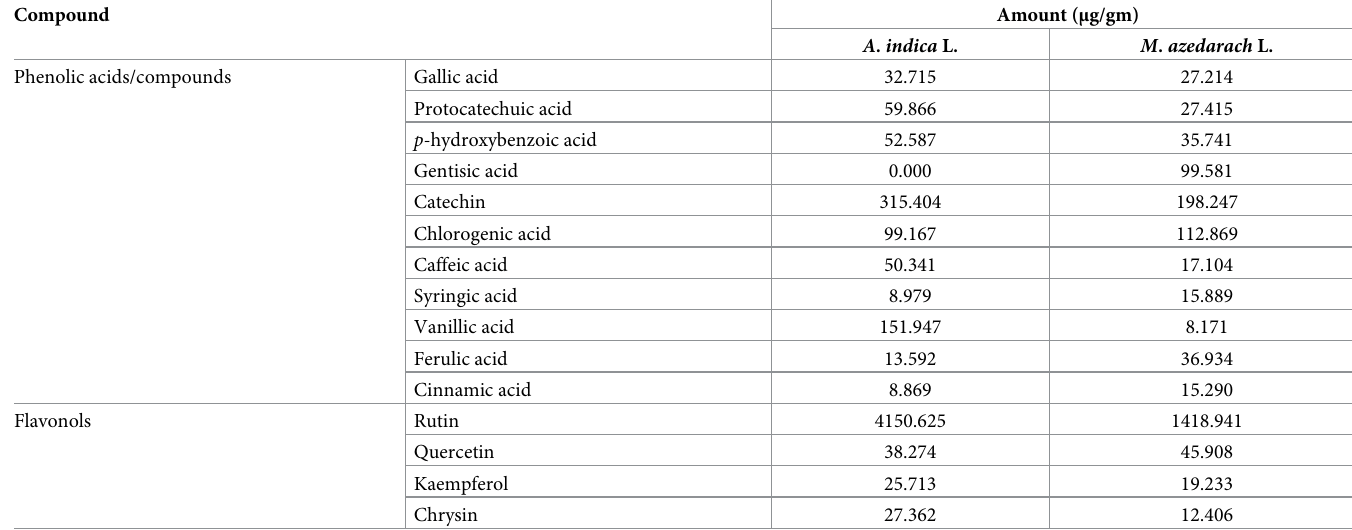
Table 1. Polyphenolic compounds content from HPLC analysis of A . indica L. and M . azedarach L. leaves ethyl acetate fractions.